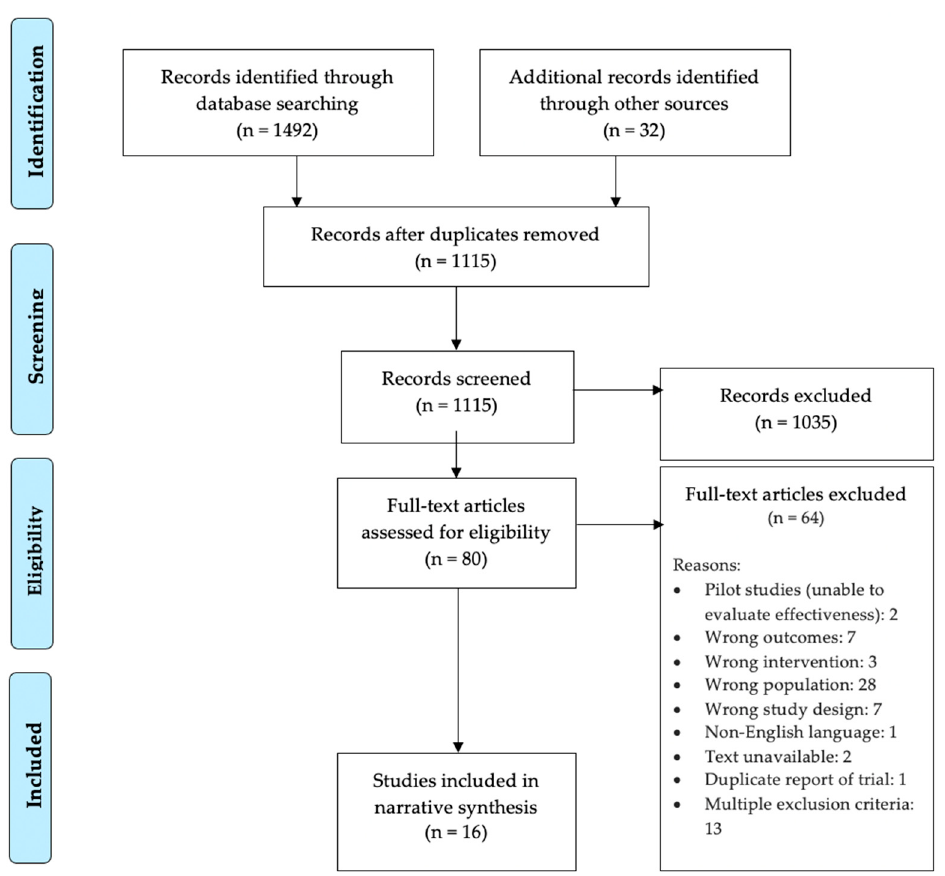
Figure 1. Prisma Flow